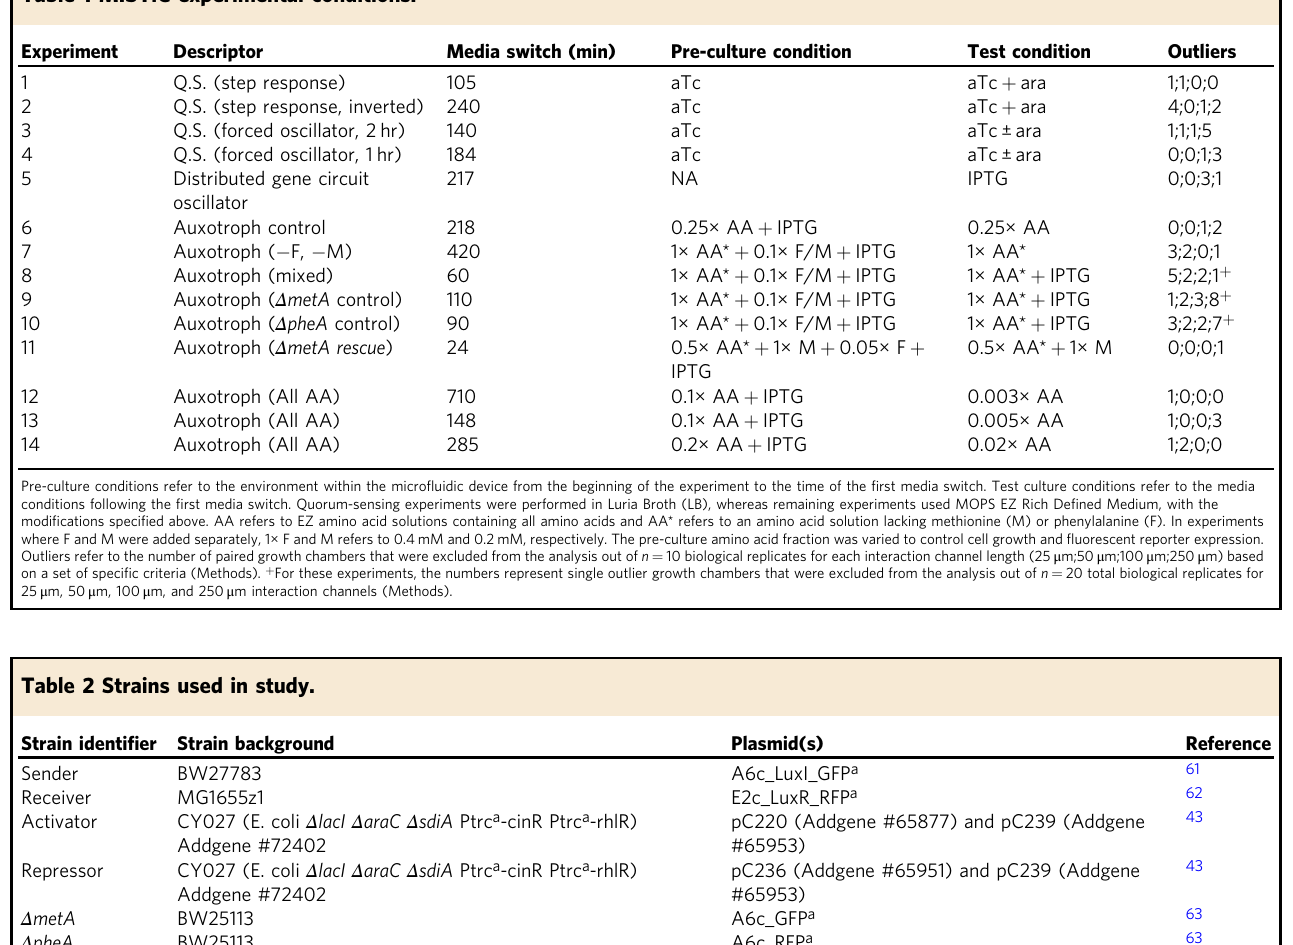
Table 1 MISTiC experimental conditions.